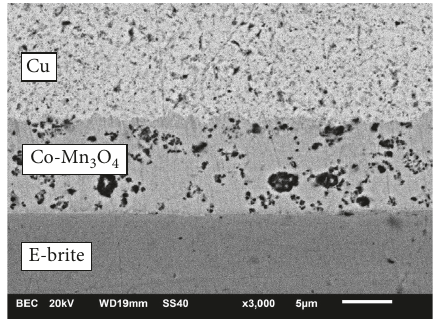
Figure 2: Cross-sectional morphology of the as-deposited Co-Mn